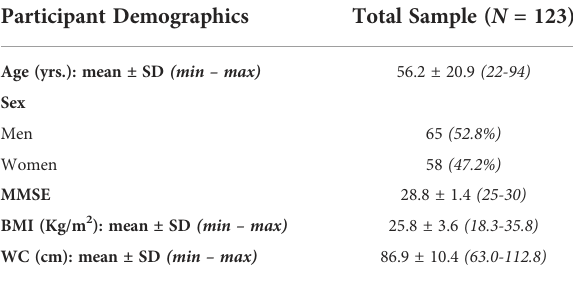
TABLE 1 Demographic characteristics of participants.